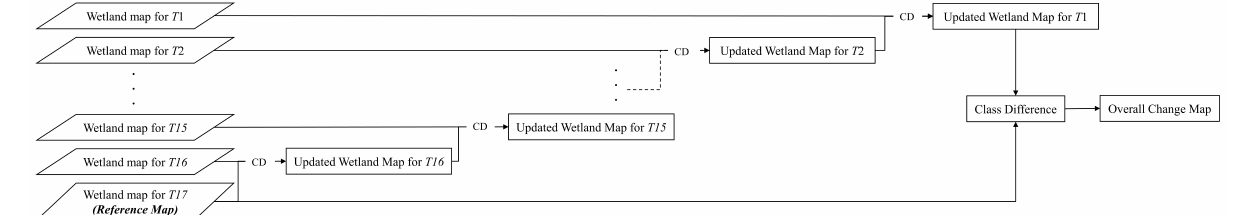
Figure 6. The method for wetland Change Detection (CD) over the entire four decades. T indicates the time interval (see Table 2) and CD is the method proposed in Figure